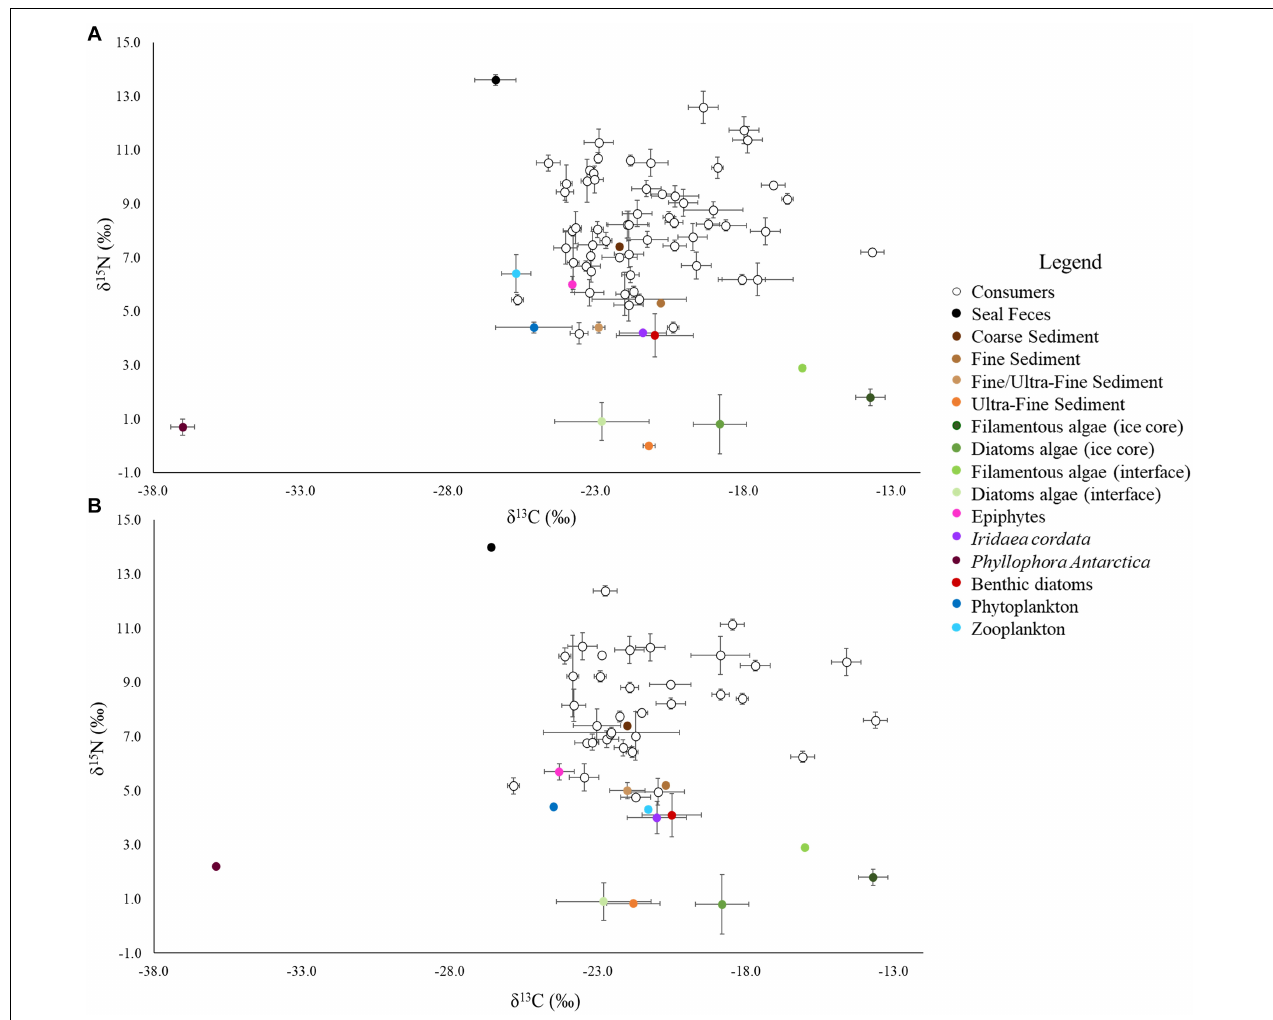
FIGURE 2 | Isotopic biplots of the BEFORE (A) and AFTER (B) communities. Each point represents a taxon. Isotopic signatures were expressed as the mean ± SE. The legend shows the respective colors of consumers and basal